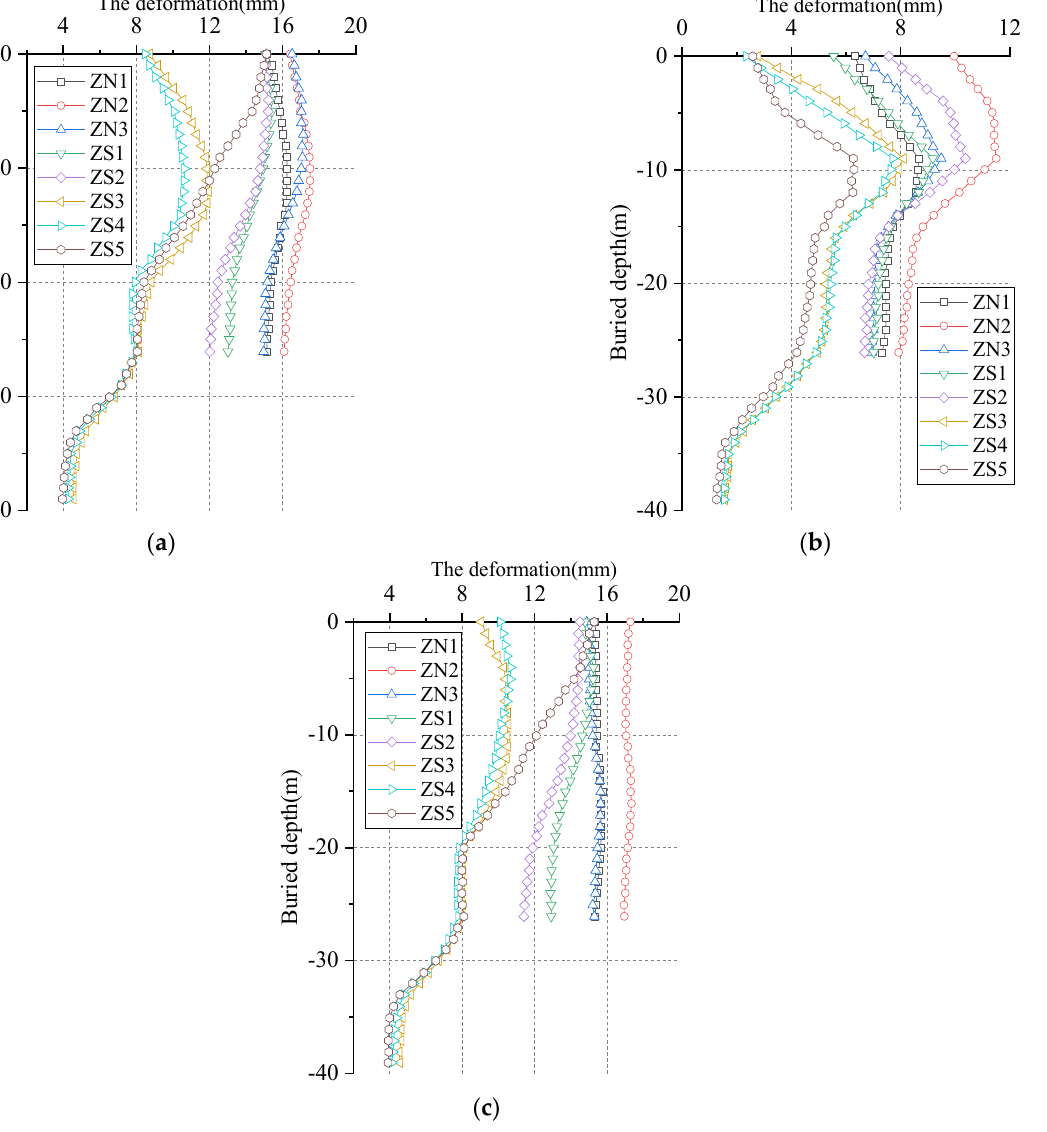
Figure 14. Deformation of the shared retaining structure. ( a ) working Condition 1. ( b ) working Condition 2. ( c ) working Condition 3.